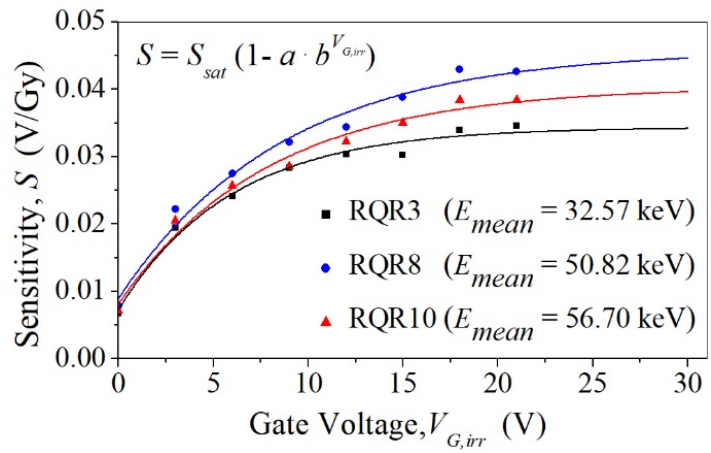
Figure 3. The S versus V G,irr fitted by Equation (7). Table 3. The parameters of Equation (7) for three beams. Table 3. The parameters of Equation (7) for three beams. X-ray